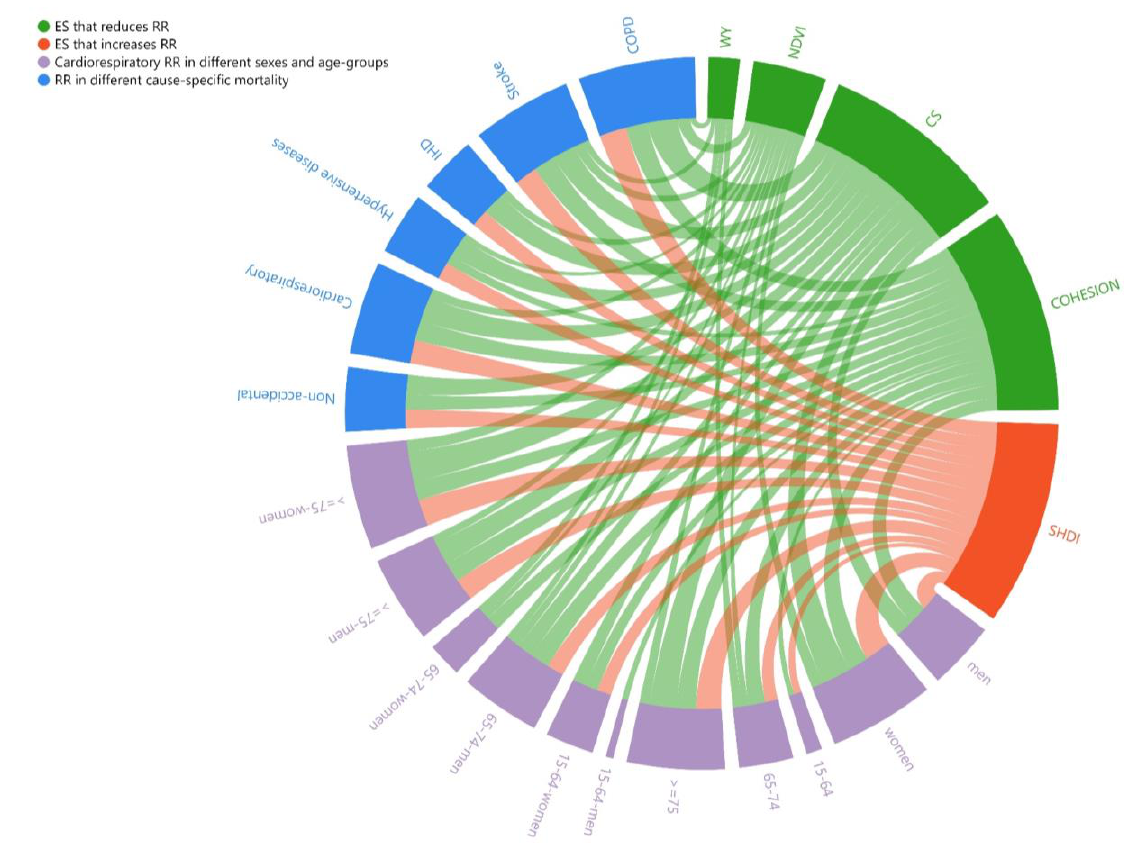
Figure 7. The mediating effects of ESs on mortality risks. Table 2. The results of mediating effects of ESs on mortality risks through HWMI.